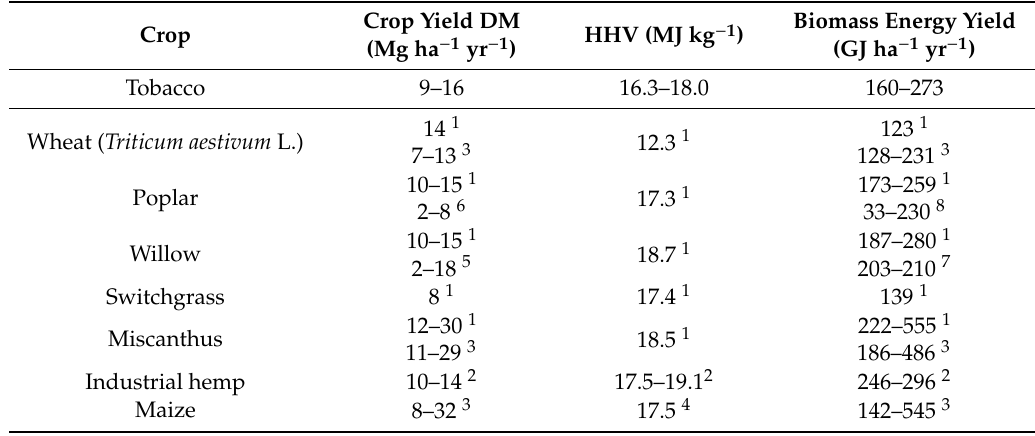
Table 4. Yields, higher heating value (HHV), and energy yield of selected energy